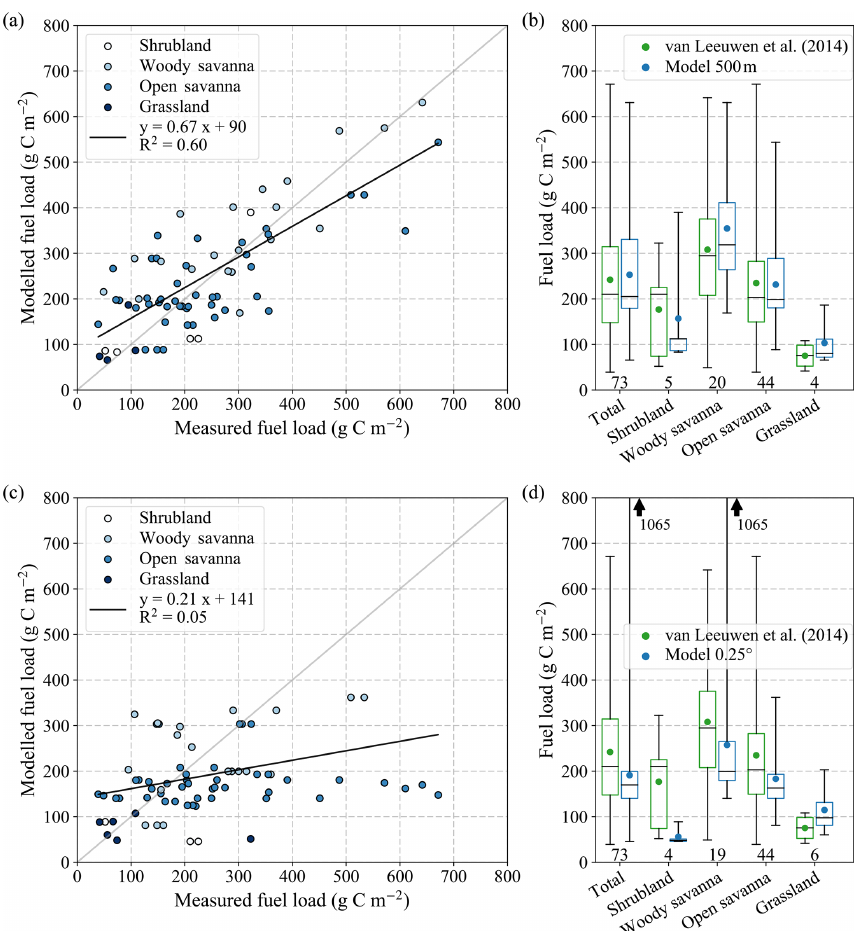
Figure 2. Comparison of modelled FL and field measurements based on calibration for 500m resolution, shown as scatter plot and boxplots per biome for (a, b) 500m resolution and (c, d) 0.25 ◦ resolution simulations. Boxplots show the mean (coloured dots), median (horizontal line), 25th and 75th percentiles (boxes), and the range of values (whiskers). The number of measurements involved is given below each